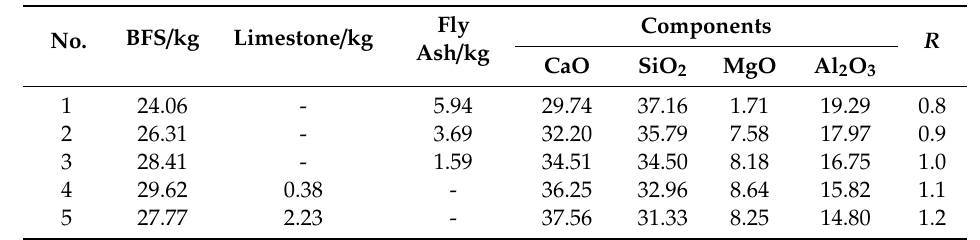
Table 2. The experimental scheme (mass fraction /